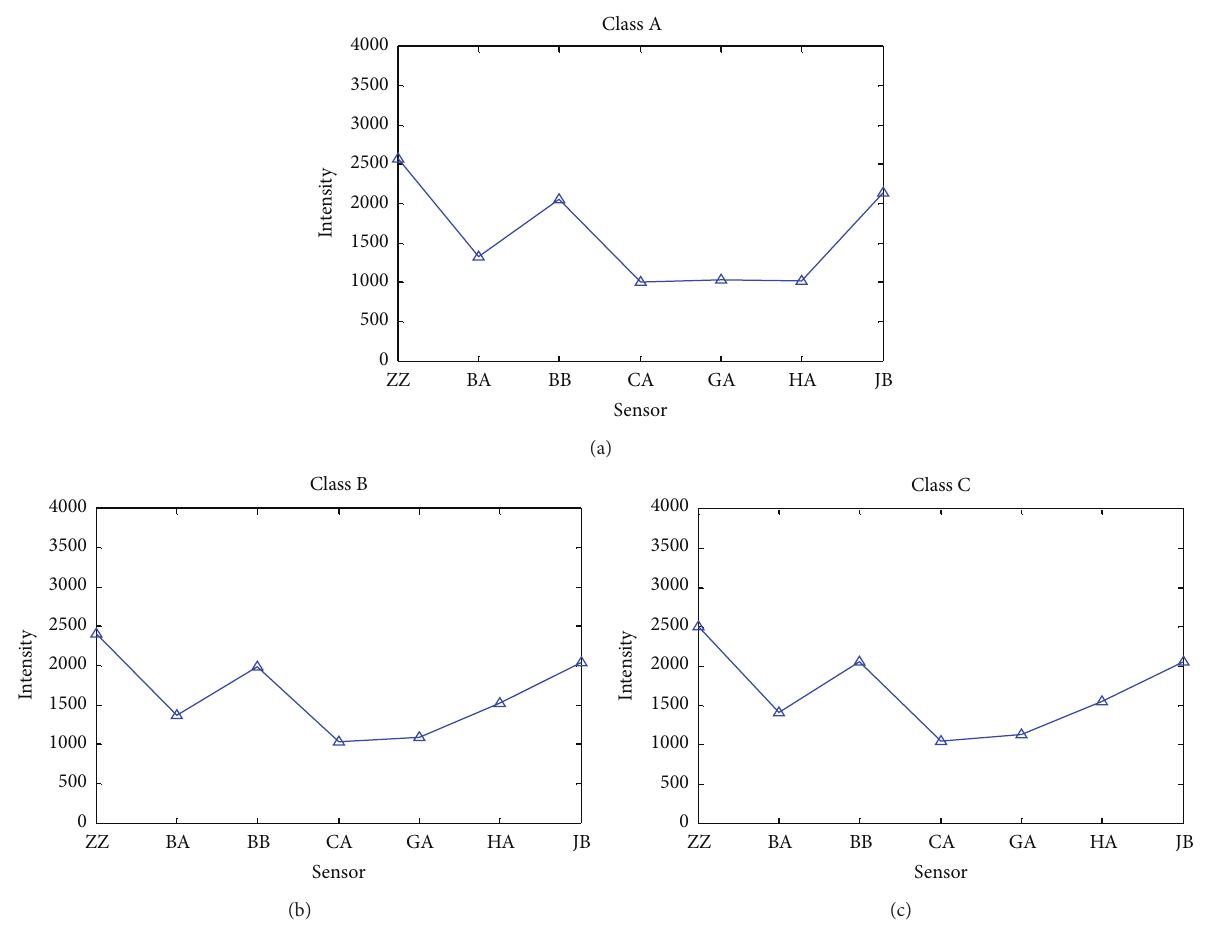
Figure 1: The average feature spectrum of Longjing tea of class A, class B, and class C.